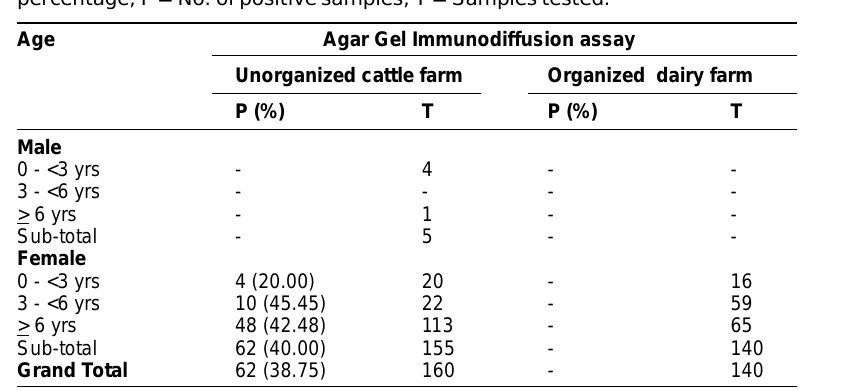
Table-1. Number of JD positive case from unorganized cattle farm and organized dairy farm with respect to age and sex. AGID assay was used to screen sera samples from both farms.